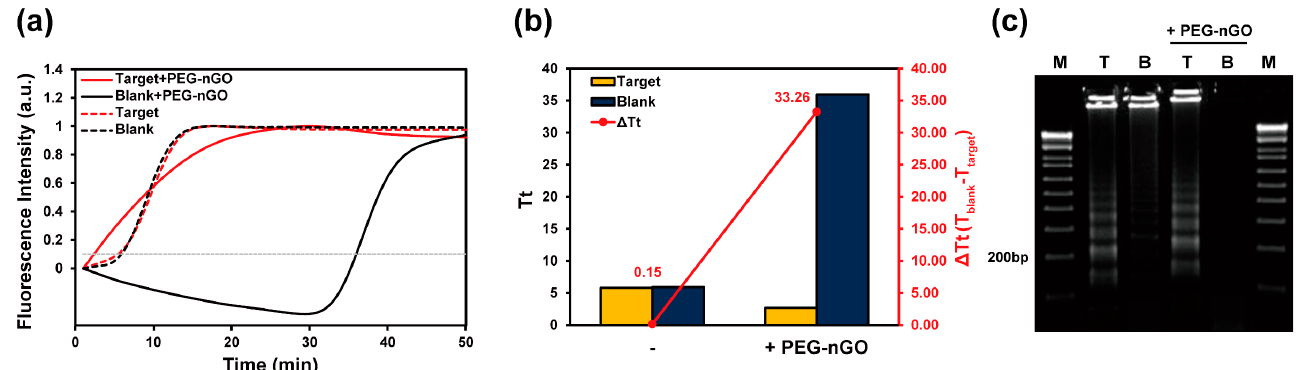
Figure 1. Facilitation of LAMP specificity by PEG-nGO. ( a ) Real − time fluorescence monitoring of LAMP − amplified products for the target and blank samples in the absence or presence of PEG-nGO. Horizontal dotted line at fluorescence intensity of 0.1 represents the threshold time (Tt), which is the time point at which 10% of the maximum amplified fluorescence intensity was utilized for signal quantification. ( b ) Tt values for target and blank samples in the absence or presence of PEG-nGO. Δ Tt values are plotted as difference between Tt of blank sample and Tt of target sample. ( c ) Agarose gel electrophoretic analysis of the LAMP − amplified products in the absence or presence of PEG-nGO. Abbreviations: M,200 bp DNA ladders; T, specific target; B, blank (double distilled water as negative control); +PEG-nGO − LAMP in the presence of PEG-nGO.